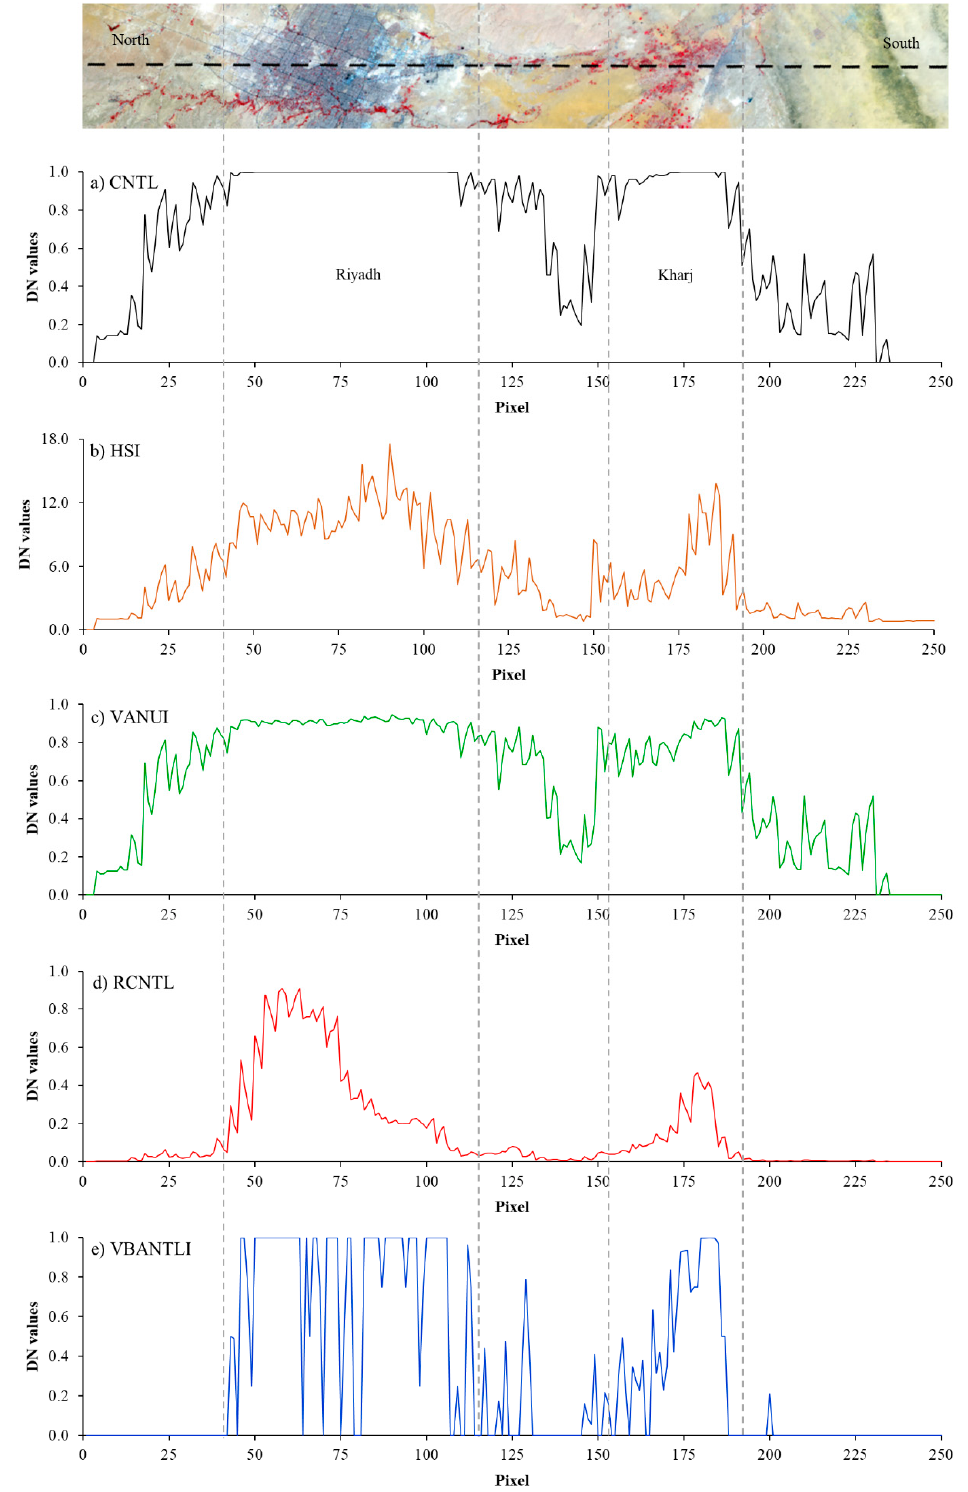
Figure 4. Longitudinal transects of Riyadh and Alkharj cities from north to south over ( a ) CNTL; ( b ) Human Settlement Index (HSI); ( c ) Vegetation Adjusted Normalized Urban Index (VANUI); ( d ) RCNTL and ( e ) the Vegetation-Bare Adjusted NTL Index (VBANTLI).